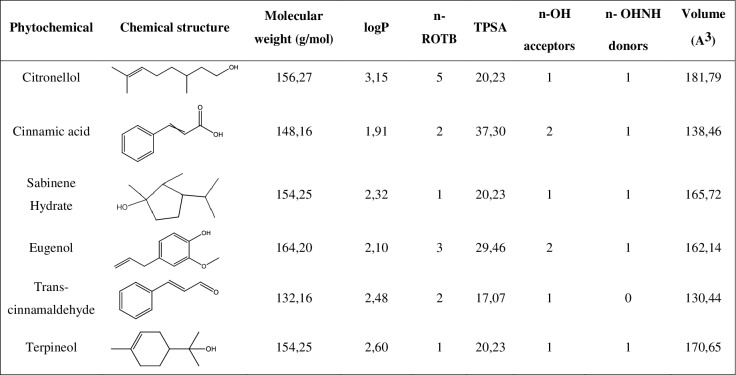
Chemical structure and molecular properties of selected phytochemicals.LogP, octanol-water partition coefficient; n-ROTB, number of rotable bonds; TPSA, topological polar surface area; n-OH, number of hydrogel bond acceptors; n-OHNH, number of hydrogen bond donors.